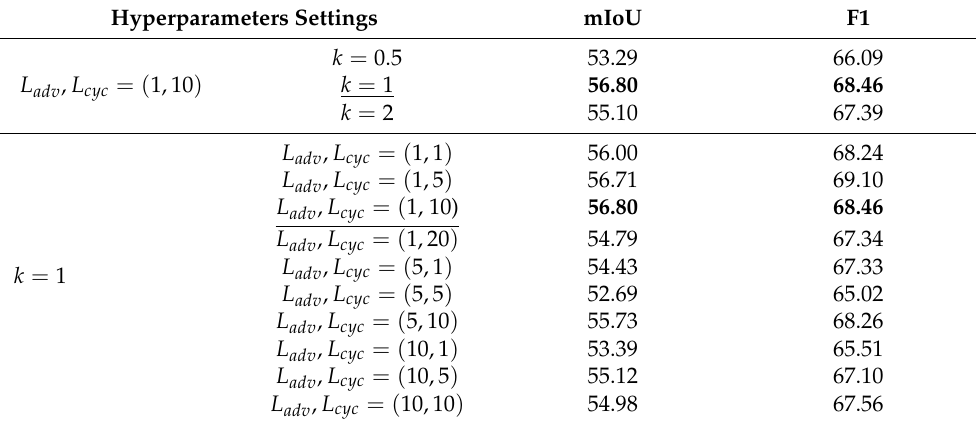
Table 4. Evaluation results of ResiDualGAN under different hyperparameter settings. The results are obtained from the task of cross-domain semantic segmentation from PotsdamIRRG to Vaihingen and evaluated on the validation part of Vaihingen. The mIoU and F1 are overall IoU and overall F1-score,